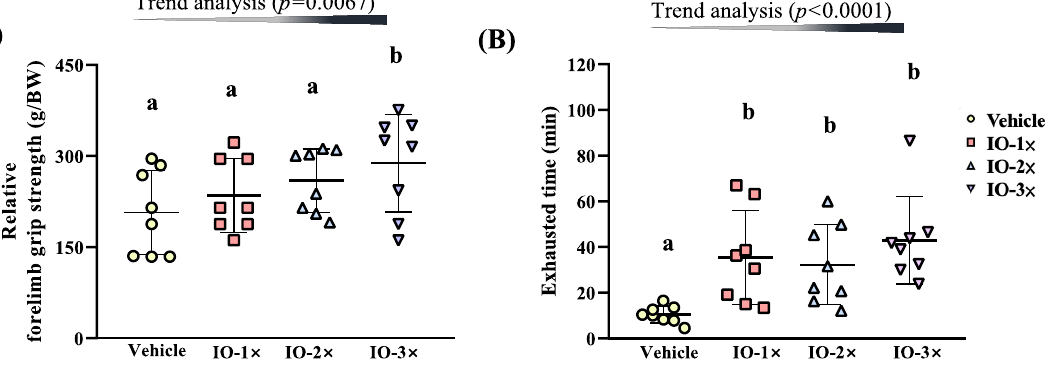
Figure 3. Effect of IO supplementation on exercise performance ( A ) Relative forelimb grip strength and (B) Exhausted treadmill test. Male ICR mice were pretreated with the vehicle, IO-1 × , IO-2 × , and IO-3 × and underwent an exercise performance test 1 h after the final administered dose. Different letters (a, b) indicate a significant difference at p < 0.05.